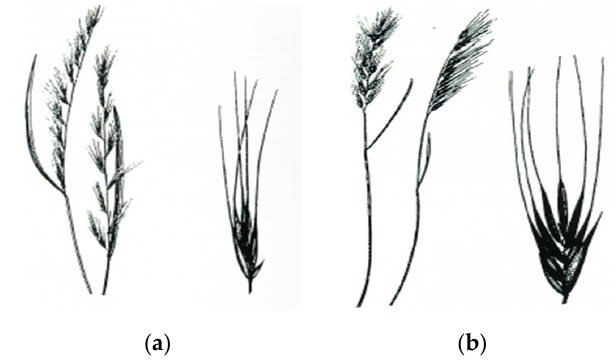
Figure 1. Panicle and spikelet of ( a ) V. myuros and ( b ) V. bromoides.